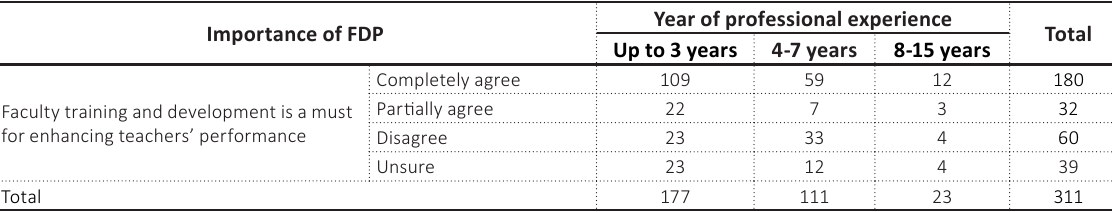
Table 2. Influence of faculty training and development on faculty performance Importance of FDP